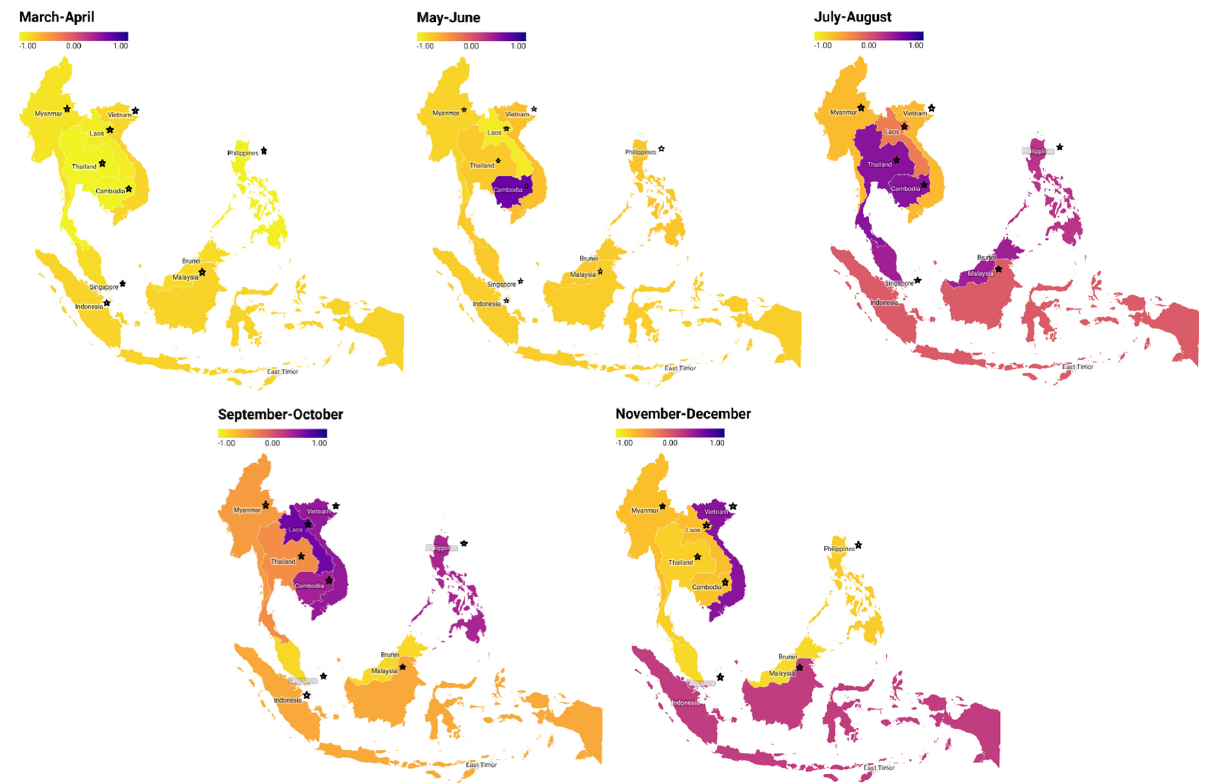
Figure 3. Path coefficients of government responses to community mobility in each country from the bi-monthly analysis. A star indicates a significant coefficient ( p < 0.05). A negative value suggests that the government response could have reduced the community mobility.